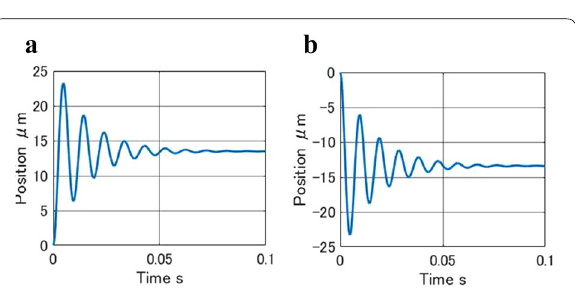
Fig. 6 Responses of e ′ 1 ( t ) and e ′ 2 ( t ) for step force reference. a Response of e ′ 1 ( t ), b Response of e ′ 2 ( t